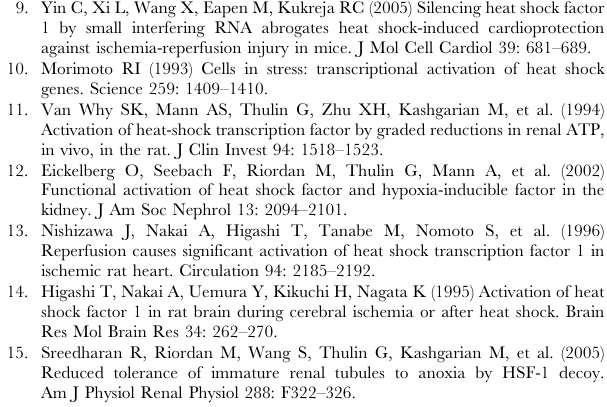
Table S2 TUNEL data obtained following morpholino (MO) microinjection, heat shock preconditioning and/ or hypoxia and reperfusion in zebrafish embryos. Data were obtained from counts of TUNEL ( + ) nuclei in embryos subjected to injection with control (CN) or HSF1 antisense